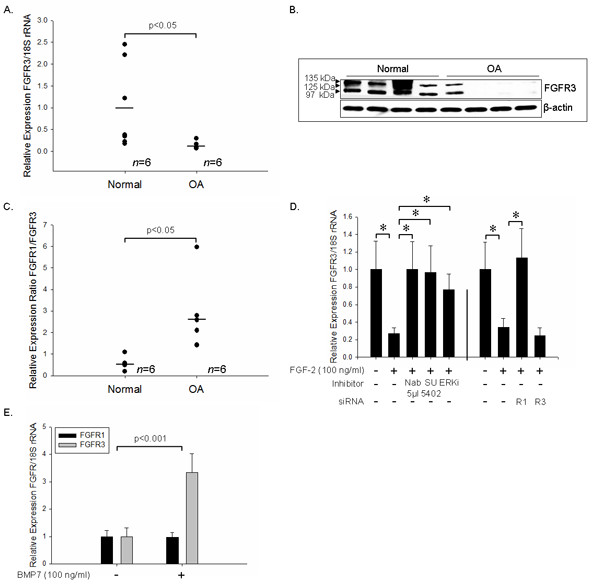
FGFR expression profiles and FGFR3 regulation in articular chondrocytes. (A) Age-matched, normal and osteoarthritic human articular chondrocytes in monolayer were subjected to RNA extraction, cDNA synthesis, and qPCR quantification of FGFR3 expression. (B) Age-matched, normal and osteoarthritic human articular chondrocytes were directly lysed for immunoblotting analyses of FGFR3. (C) Age-matched, normal and osteoarthritic chondrocytes were subjected to RNA extraction, cDNA synthesis, and qPCR quantification of FGFR1 and FGFR3 expression. The FGFR1 to FGFR3 expression ratio was calculated in each donor. (D) Human articular chondrocytes in monolayer were pre-incubated with SU5402 (5 μM) or PD98059 (ERK inhibitor, 50 μM) for 1 hour, and then treated with FGF-2 (100 ng/mL) for 24 hours. In parallel, chondrocytes were transfected with siRNA targeting FGFR1 or FGFR3, and then stimulated by FGF-2 (100 ng/mL) for 24 hours. Total RNA was extracted afterwards for cDNA synthesis and qPCR analyses of FGFR3 expression. * P < 0.05. (E) Human articular chondrocytes in monolayer were administered with BMP7 (100 ng/mL) and cultured for 24 hours. Total RNA was extracted afterwards for cDNA synthesis and qPCR analyses of FGFR1 and FGFR3 expression. ERK, extracellular signal-regulated kinase; FGF, fibroblast growth factor; FGFR, FGF receptor; qPCR, quantative polymerase chain reaction.